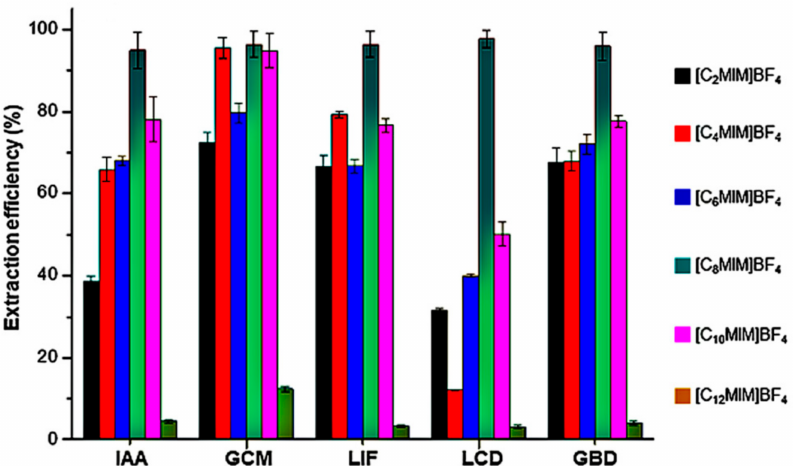
Figure 5. Influences of different ILs on extraction efficiency of GBD, LCD, LIF, GCM and IAA from licorice [59]. Reprinted with permission of